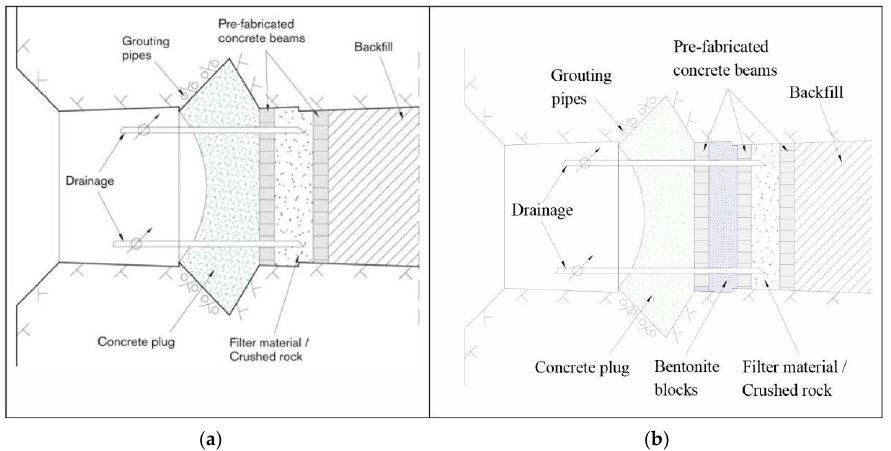
Figure 12. Design of short reinforced concrete plug without ( a ) and with an intermediate bentonite layer ( b ) between the filling of the tunnel and the plug itself [49]. Based on the experimental reports of the Ä spö [54 – 56] hard rock laboratory, SKB has opted for a short reinforced plug with an intermediate layer of bentonite. The use of low- alkaline concrete is explained by the need to preserve the bentonite buffer’s previous swelling ability, which is severely degraded in the strong alkaline solutions formed by filtering underground water through concrete structures [49].